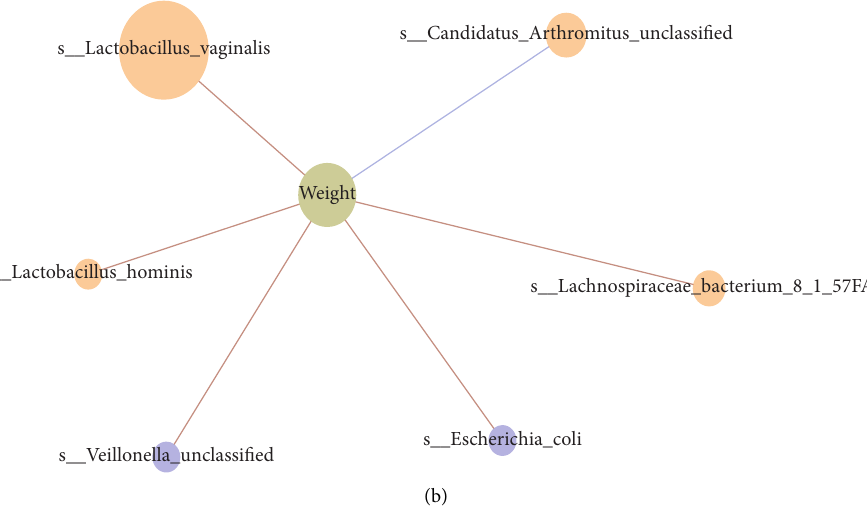
Figure 4: Estrogen deficiency leads to an increase in mouse weight and alters the abundance of gut microbiota species related to weight. (a) The boxplot shows the mouse weights of the model and control groups. The weight of the OVX group mice significantly increased compared to that of the control group mice. The p value was calculated by the Wilcoxon rank-sum test and corrected by the BH method. (b) The gut microbiota species were related to mouse weight. The red line represents the gut microbiota species that were positively correlated with mouse weight (Spearman’s correlation coefficient > 0.3 and Spearman’s p value < 0.05). In contrast, the blue line represents the species that were negatively associated with mouse weight (Spearman’s correlation coefficient < -0.3 and Spearman p value < 0.05). The blue nodes represent the species that were enriched in the OVX group mice at the T2-T4 time points, while the nodes in light orange represent the irregular enrichment of species at different time points. The node size indicates Spearman’s p value of the gut microbiota species and mouse